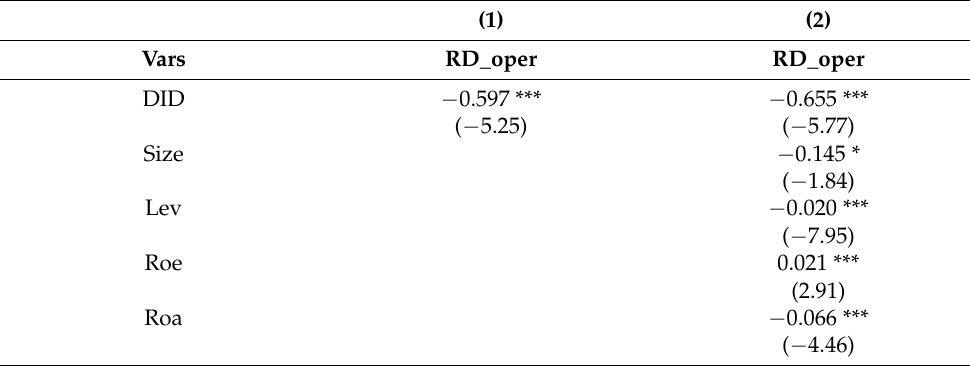
Table 3. Results of robustness